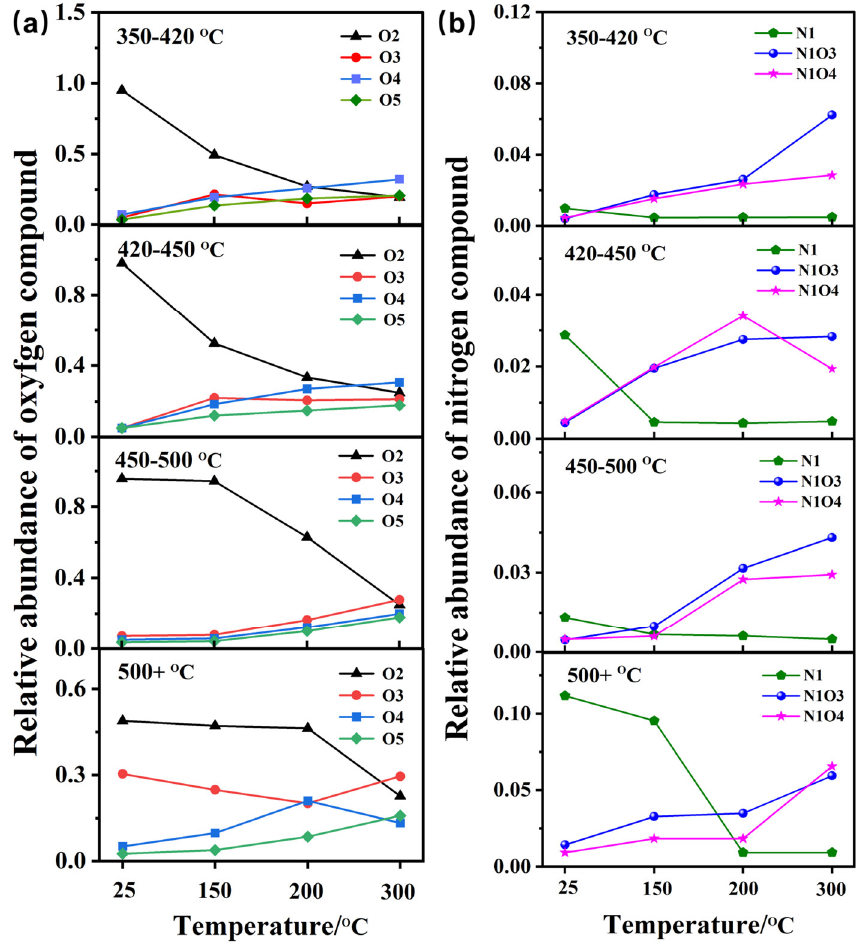
Figure 5. Heteroatom types and relative abundances of pseudo-components: ( a ) oxygen-containing compounds; ( b ) nitrogen-containing compounds.